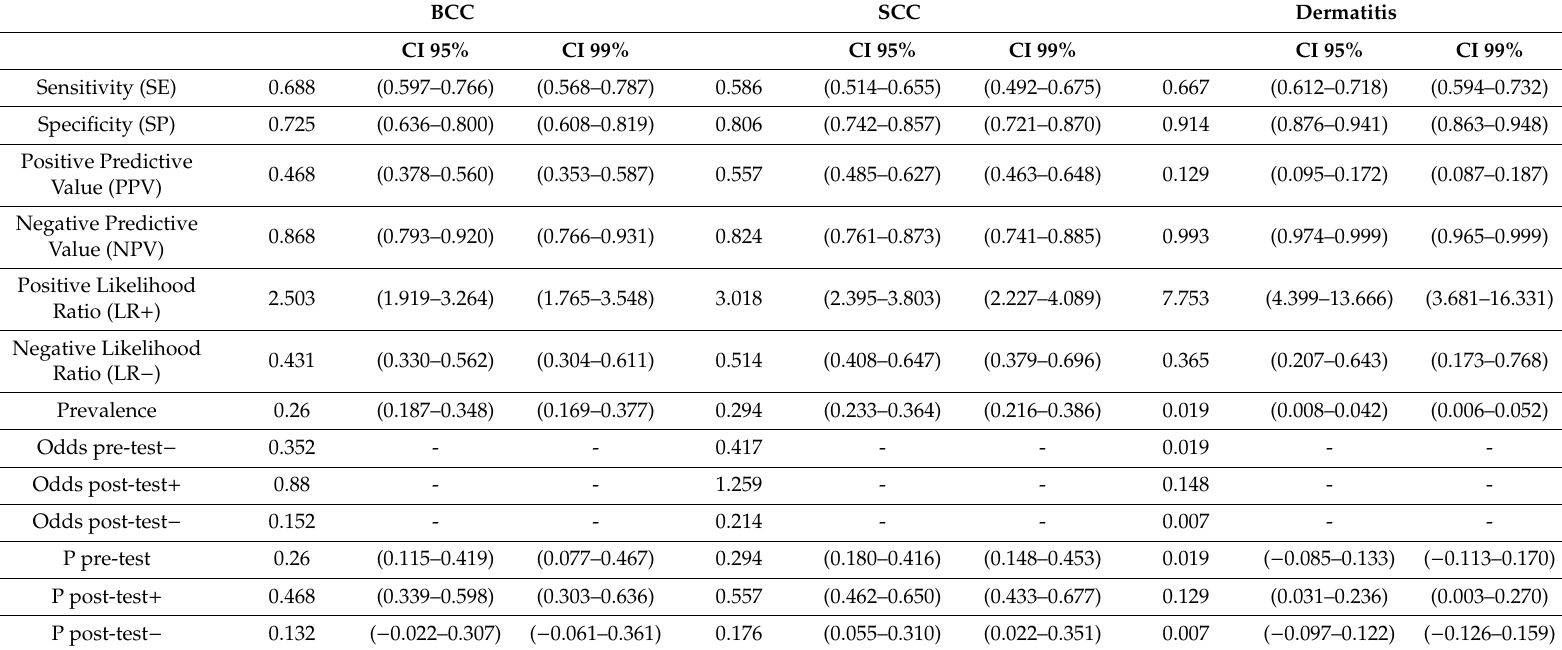
Table 3. Analysis of CA 19-9 serum positivity (n.v. <